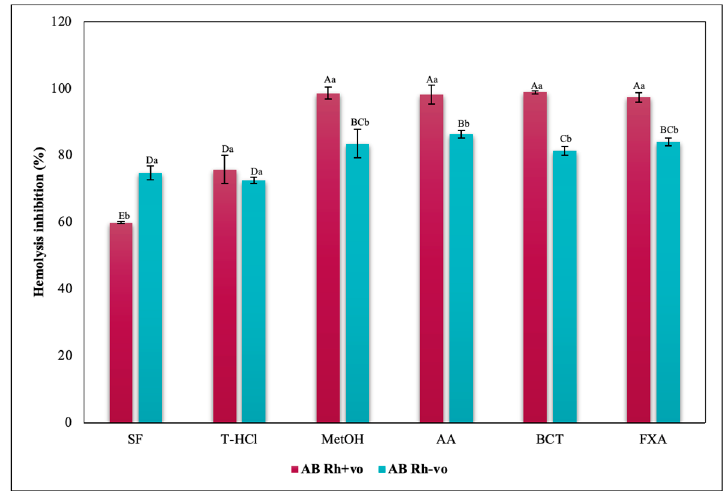
Figure 12. Inhibitory effect of hypotonicity-induced hemolysis of P. cruentum extracts on human erythrocytes with different RhD (positive and negative) of AB blood group. Different letters represent significant differences in the means between treatments and groups ( p ≤ 0.001). Capital letters represent a two-way ANOVA. Lowercase letters represent a univariate ANOVA between the extracts. PS, extract of physiological solution; T-HCl, 0.5 M Tris-HCl extract; MetOH, 99% methanol extract.